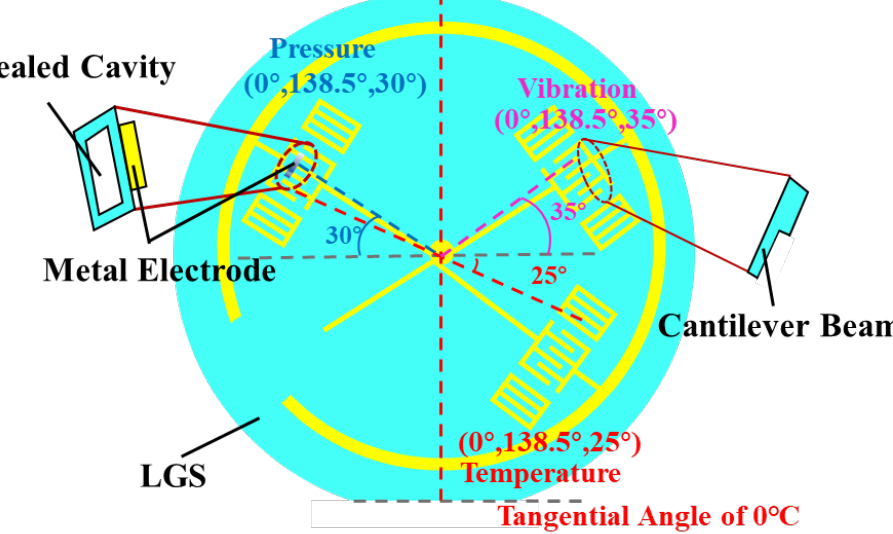
Figure 8. Multi-parameter coplanar layout.